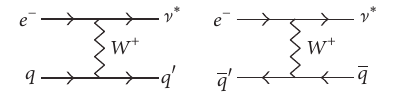
Figure 2: Feynman